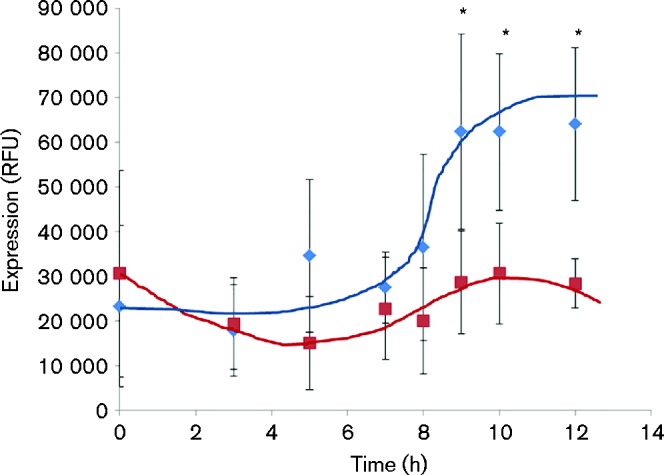
Expression of the viscA gene per biomass unit in biofilms (blue diamonds) and planktonic cells (red squares) in the initial state of biofilms grown in microtitre wells. Data represent mean ± sd for a representative experiment with five replicates. *Significant difference between biofilm and planktonic cells at each time point (P < 0.05) as well as significant difference from biofilm values at 7 h (P < 0.05).